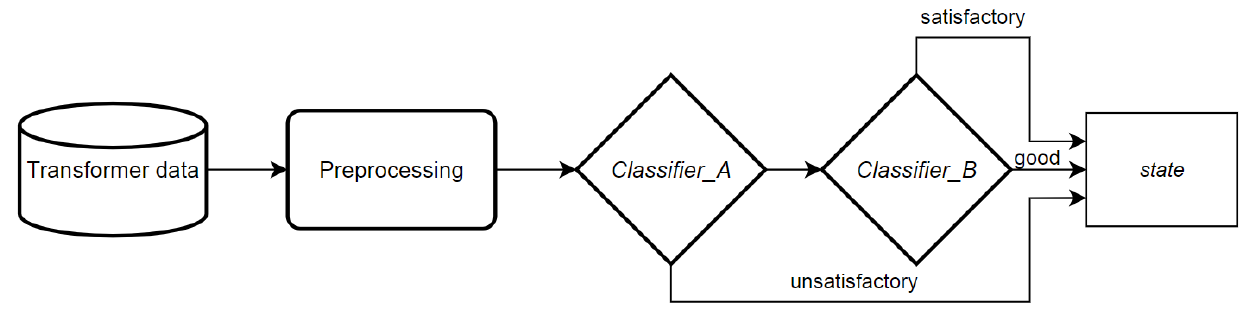
Figure 19. Model application pipeline.